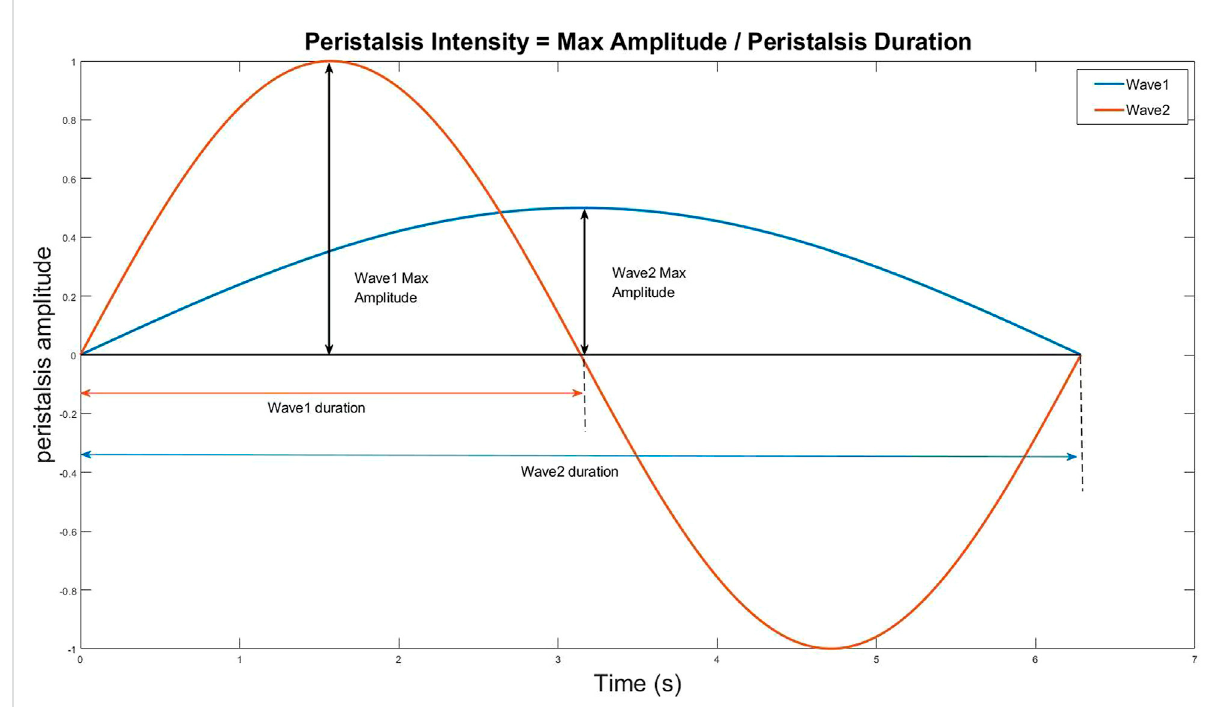
FIGURE 6 The ratio of wave peak to wavelength (i.e., the ratio of ordinate to abscissa) as the indicator of peristalsis velocity.